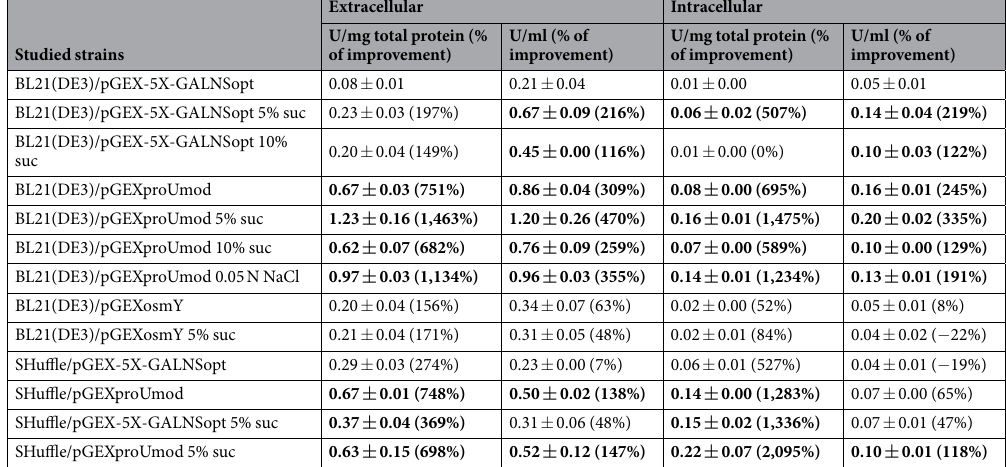
Table 2. Summary of the enzymatic rhGALNS activities obtained in this work after 24 hours of induction. Values in bold correspond to statistically significant improvements using a t-student test with a p-value <